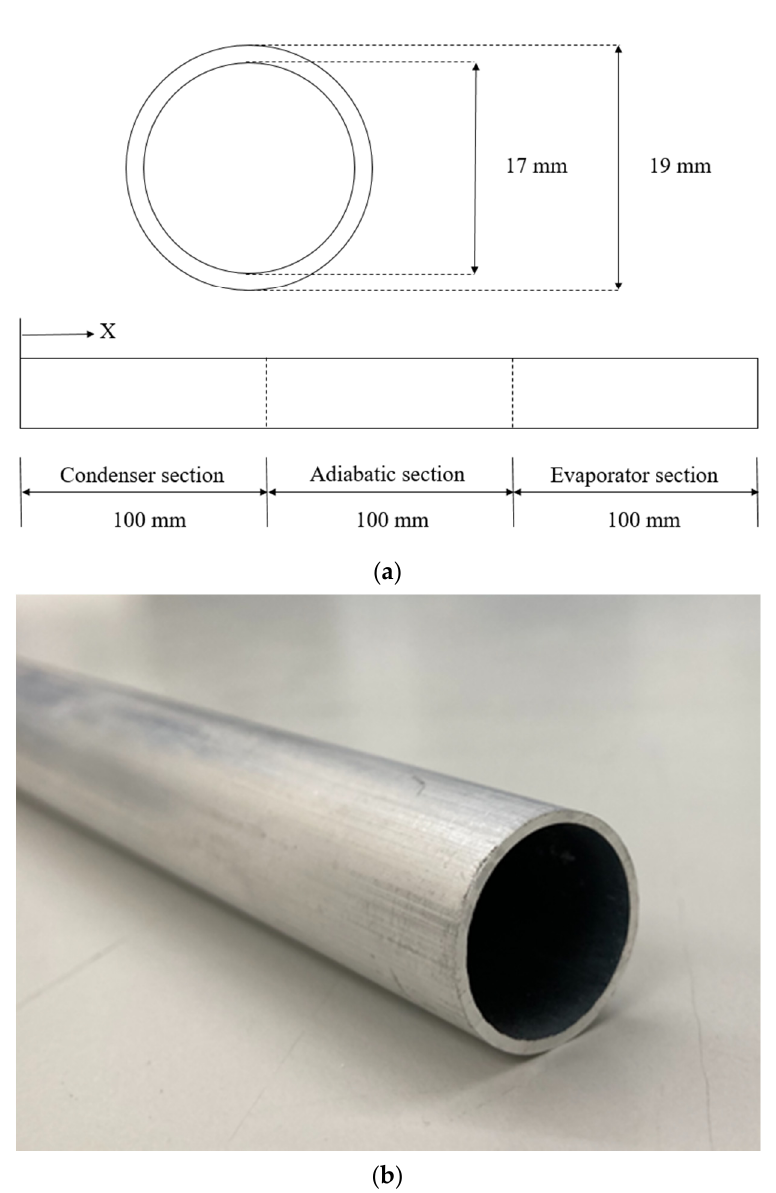
Figure 1. Aluminum alloy pipe: ( a ) schematic diagram, ( b ) photographic